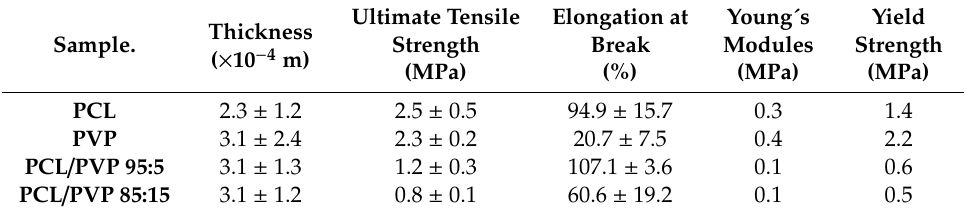
Table 1. Mechanical characteristics of fibrous PCL, PVP and PCL / PVP fibers. Thickness (mm), ultimate